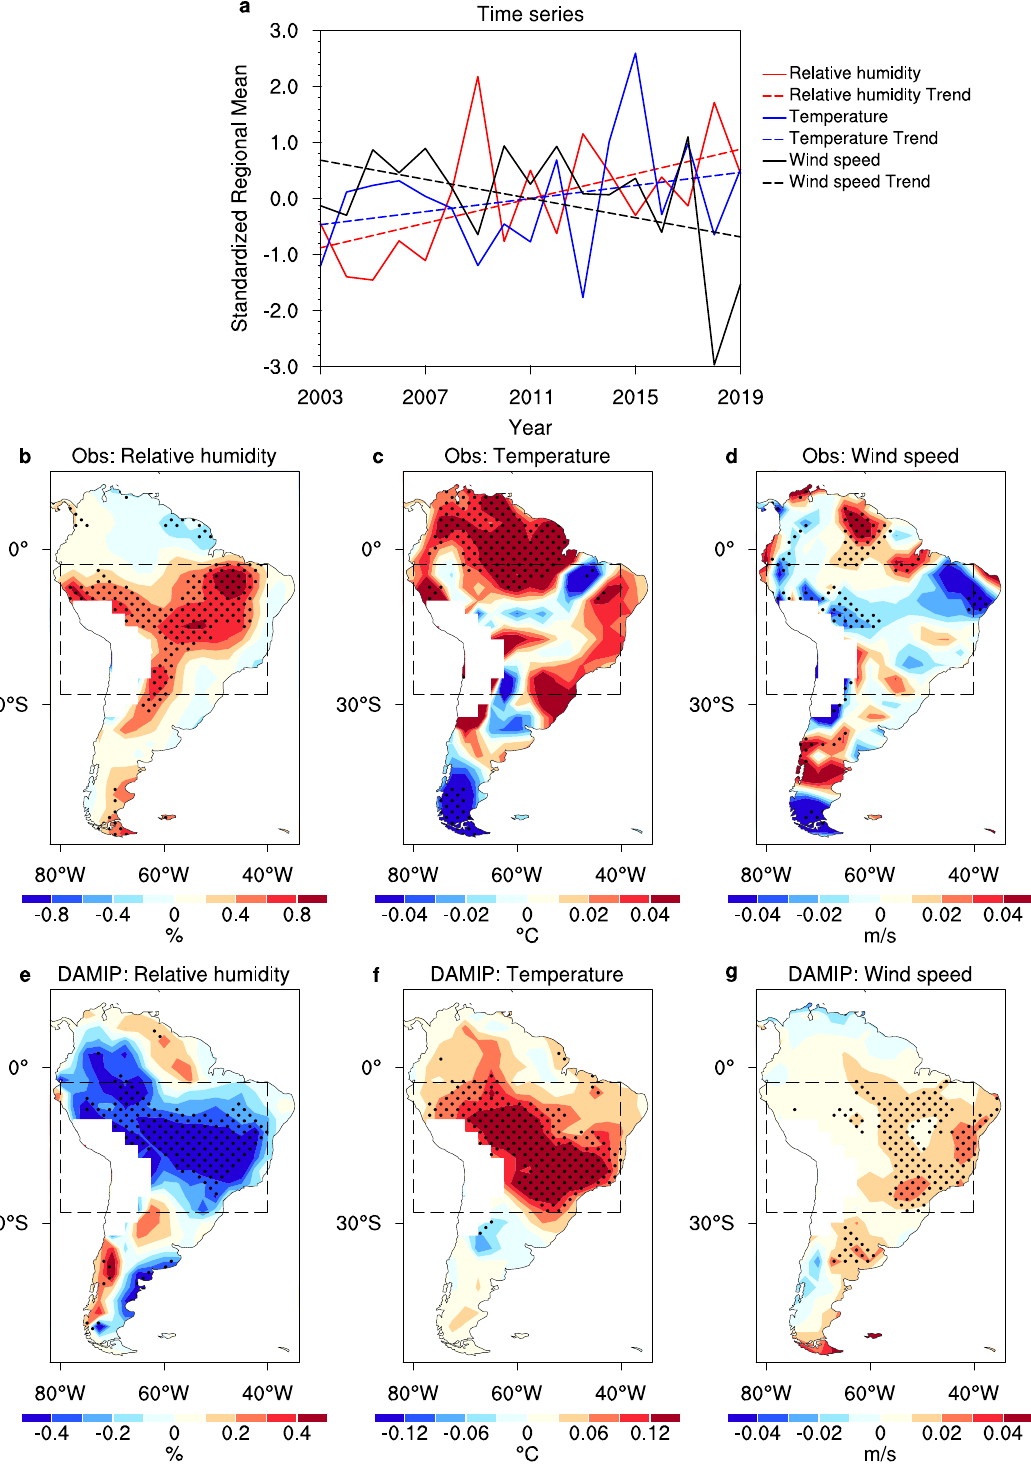
Fig. 2 Changes in the climatic conditions related to fi res in South America during the dry season. a Time series and trend of the observed standardized 925 hPa relative humidity, surface temperature, and surface wind speed in the SAP region during the time period 2003 – 2019. Long-term trends in the 925 hPa relative humidity (units: % yr − 1 ), surface temperature (units: °C yr − 1 ), and surface wind speed (units: m/s yr − 1 ) from b – d the observations (2003 – 2019) and e – g anthropogenic forcing effects in the DAMIP dataset (2003 – 2014). Stippling indicates passing the Mann – Kendall test at the 0.1 signi fi cance